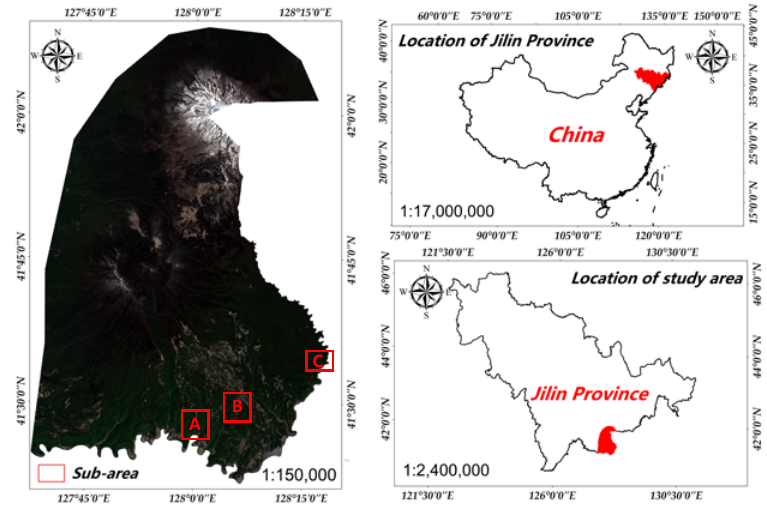
Figure 1. Study area with sub-areas A through C.